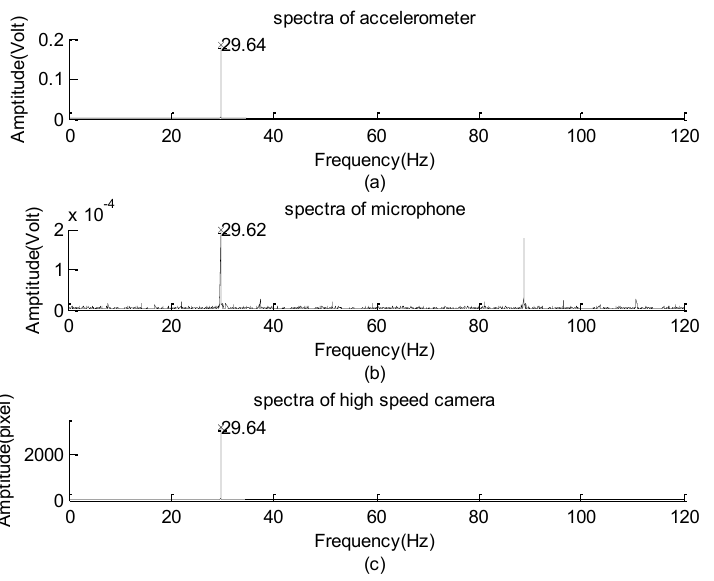
Figure 9. Comparison of the frequency response of the vibration exciter’s signal, input frequency is about 30 Hz: ( a ) spectra of accelerometer. ( b ) spectra of microphone. ( c ) spectra of high speed